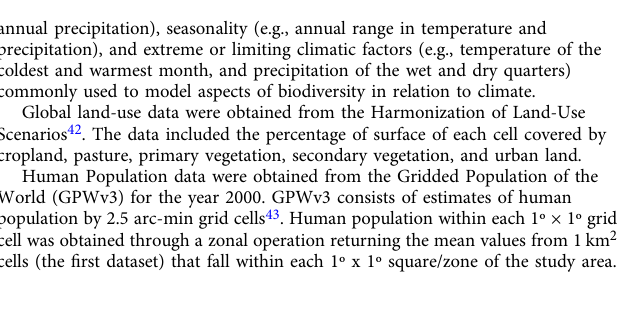
Fig. 4 Relationship between transitions in trophic structures and human impacts. a World distribution of differences between observed and predicted trophic structures (i.e., transitions). b Tree model linking human impacts to trophic structure transitions from boreal or temperate to depauperate. c Tree model linking human pressures to trophic structure transitions from tropical to semi-arid. Terminal nodes indicate the number of cells in the category ( n ) and the ratio of cells in each category (indicated in the y -axis, see